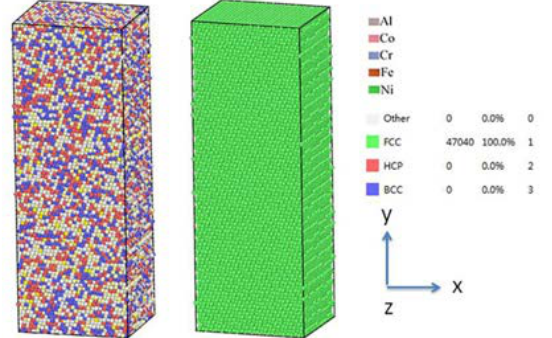
Figure 2. Three-dimensional structure of non-GBs HEAs .